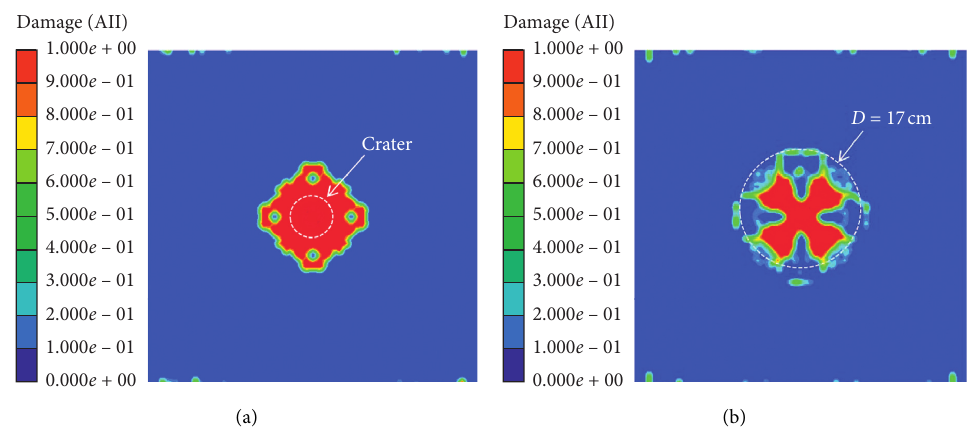
Figure 17: Simulation results under spherical explosive. (a) Upper surface. (b) Bottom surface.